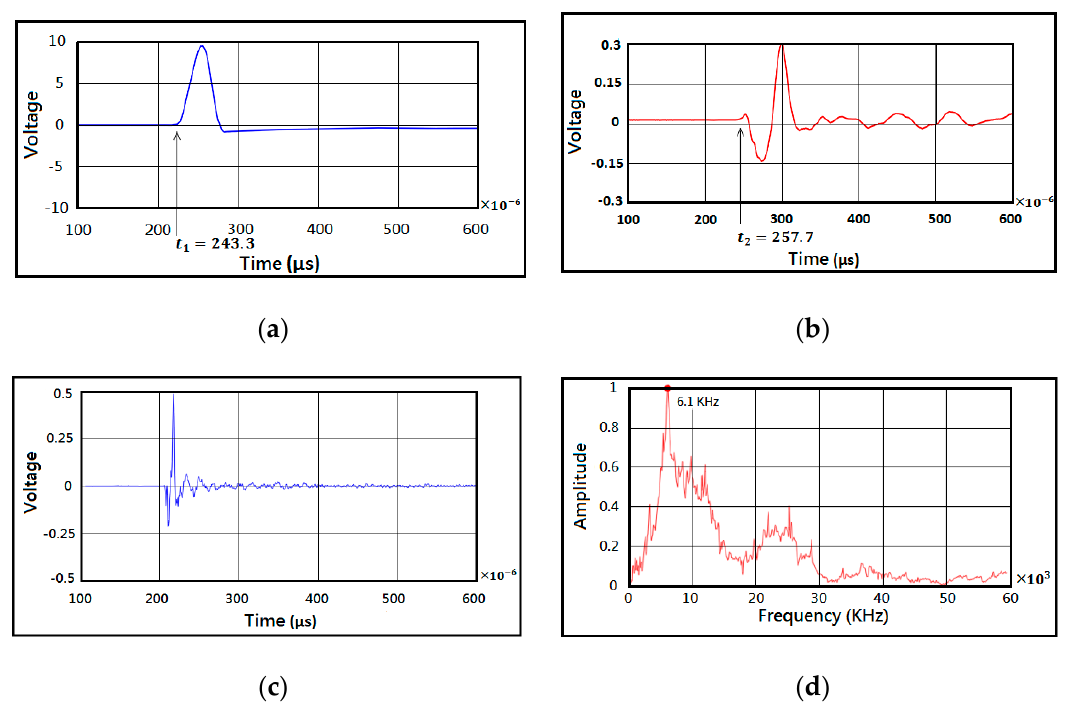
Figure 11. Regular concrete impact wave graph from striking the other side of the object: ( a ) incident impact point wave graph; ( b ) first reflected wave waveform graph; ( c ) MATLAB simulation graph; ( d ) spectrogram.